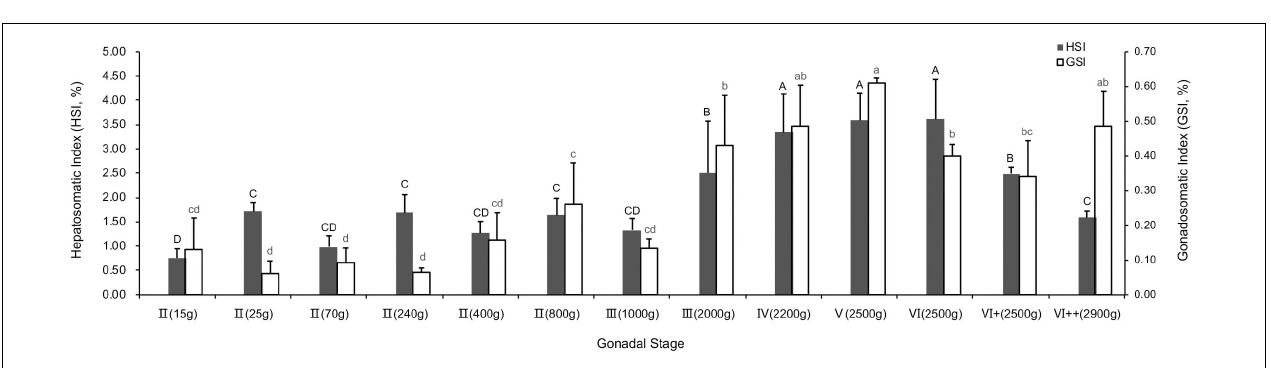
FIGURE 2 | Hepatosomatic index (HSI) and gonadosomatic index (GSI) of different gonadal stages. P < 0.05, n =